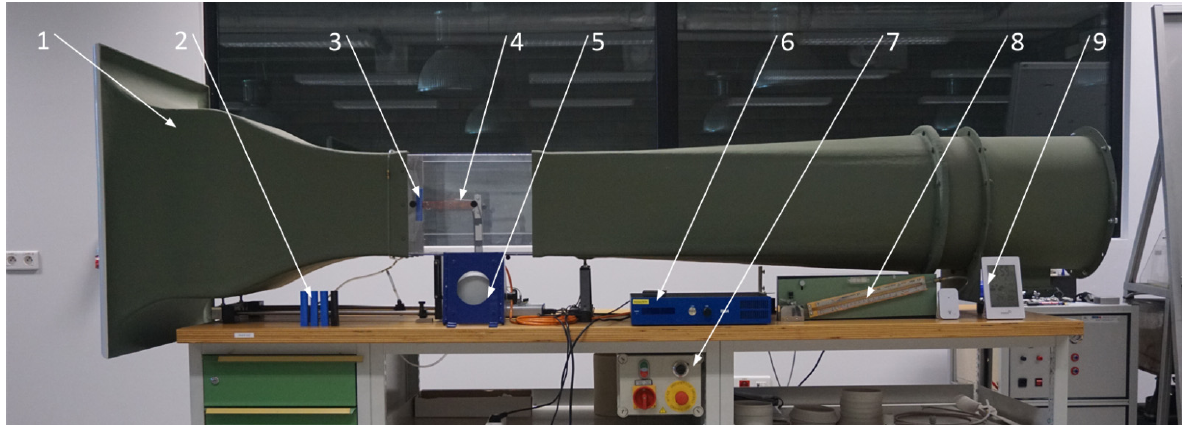
Figure 1. General view of the experimental test rig. 1, HM 170 open wind tunnel (GUNT Hamburg); 2, set of the studied bluff bodies; 3, bluff body in the test section; 4, cantilever beam with the piezo-element; 5, vibration generator; 6, digital amplifier; 7, control panel of the wind tunnel; 8, measurement of air-flow velocity; 9, weather station.